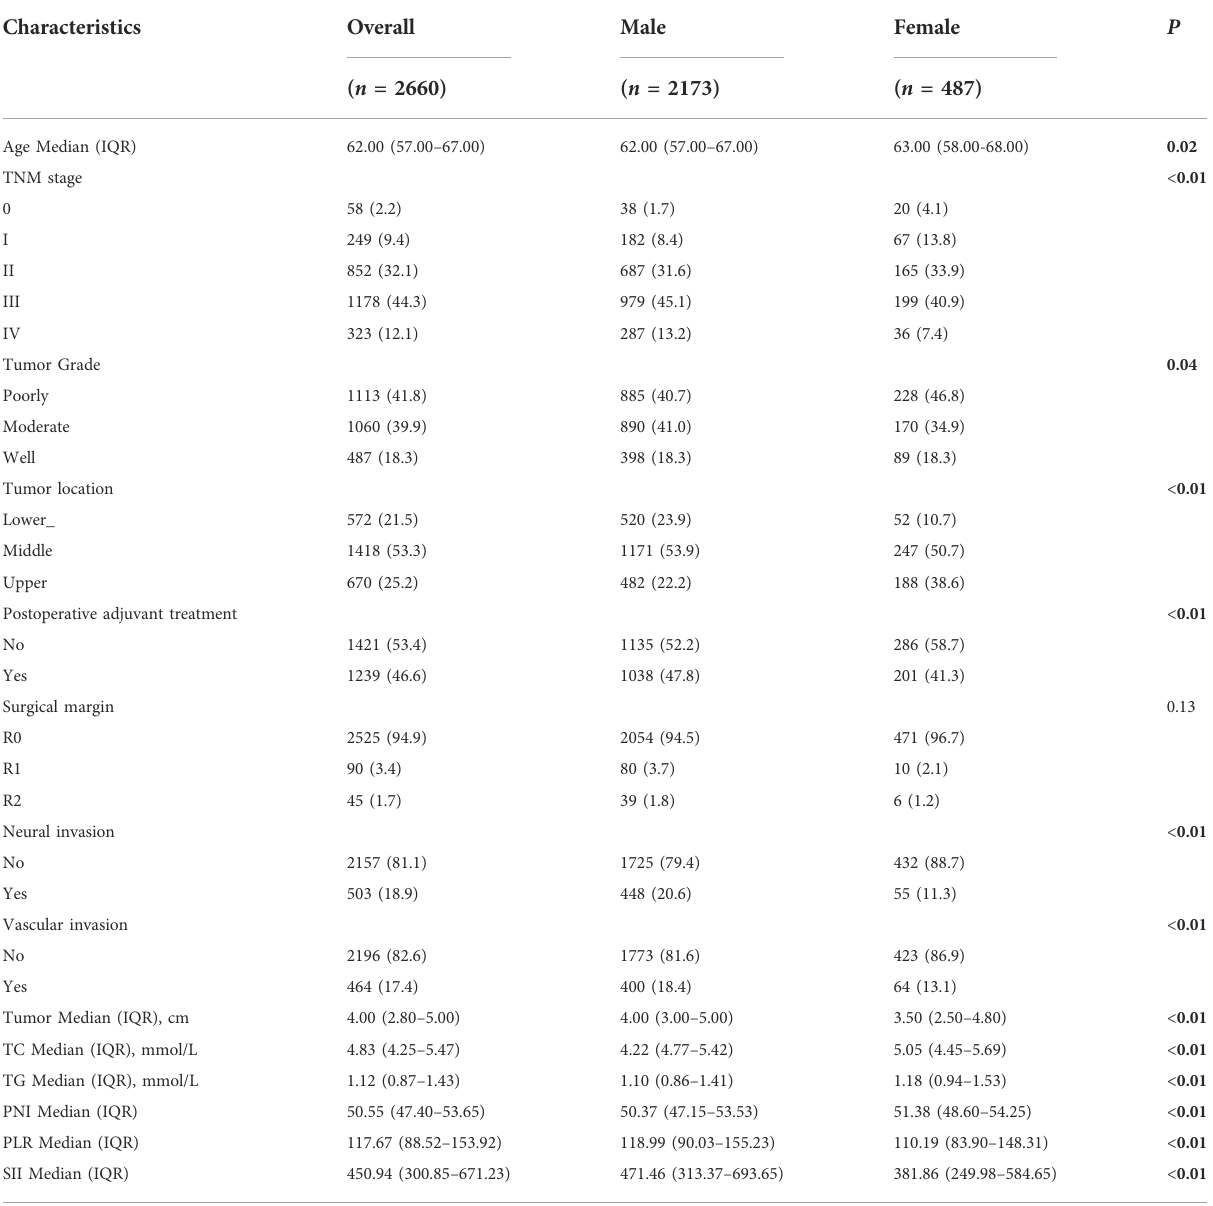
TABLE 1 Patient characteristics of total